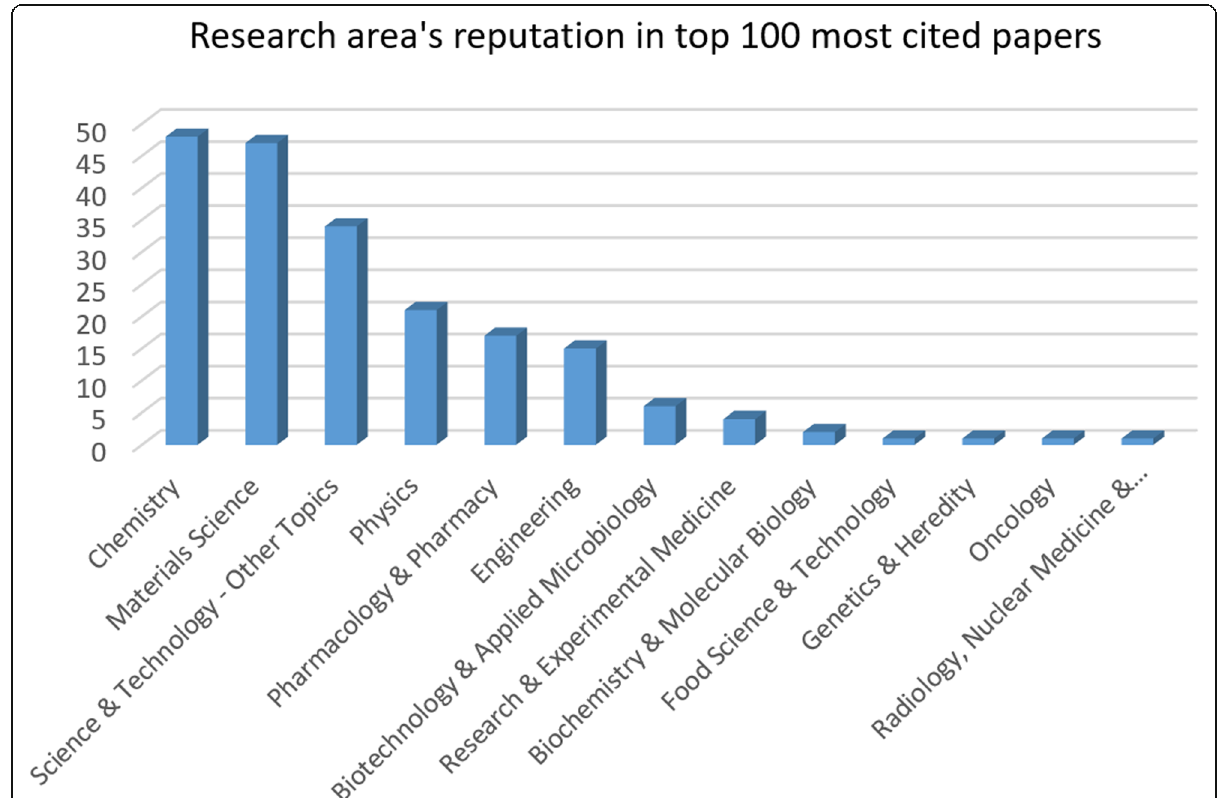
Fig. 8 Research areas sorted by the number of articles published